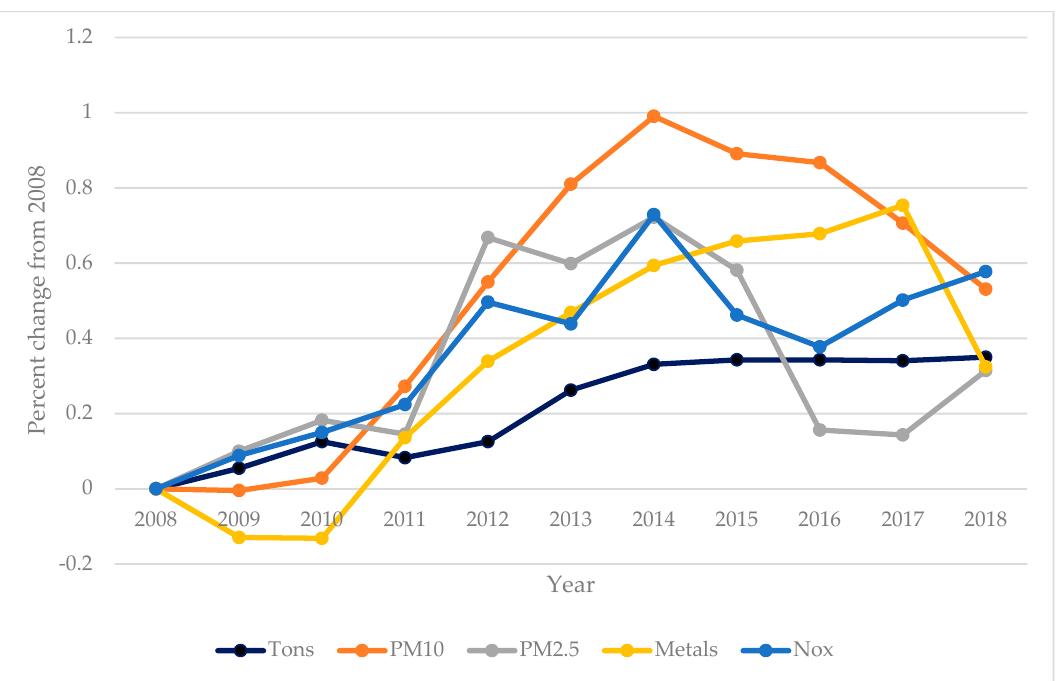
Figure 3. Percent change from 2008 in tons of coal production and in pollution emissions.